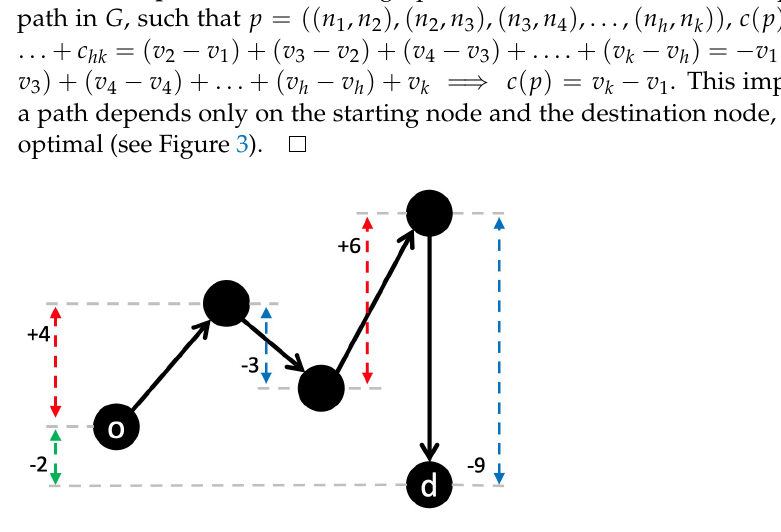
Figure 3. Example of a graph in which the cost of an arc depends on the elevation of the